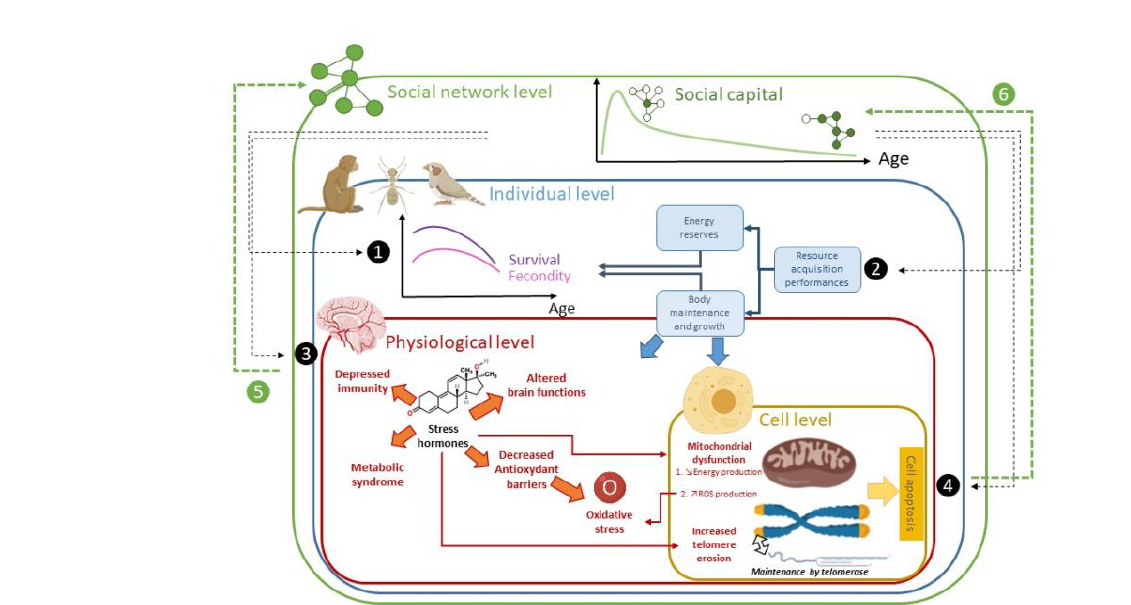
Figure 1: Schema of the proposed mutual influence of social capital, chronological age and biological age, from the cell level to the